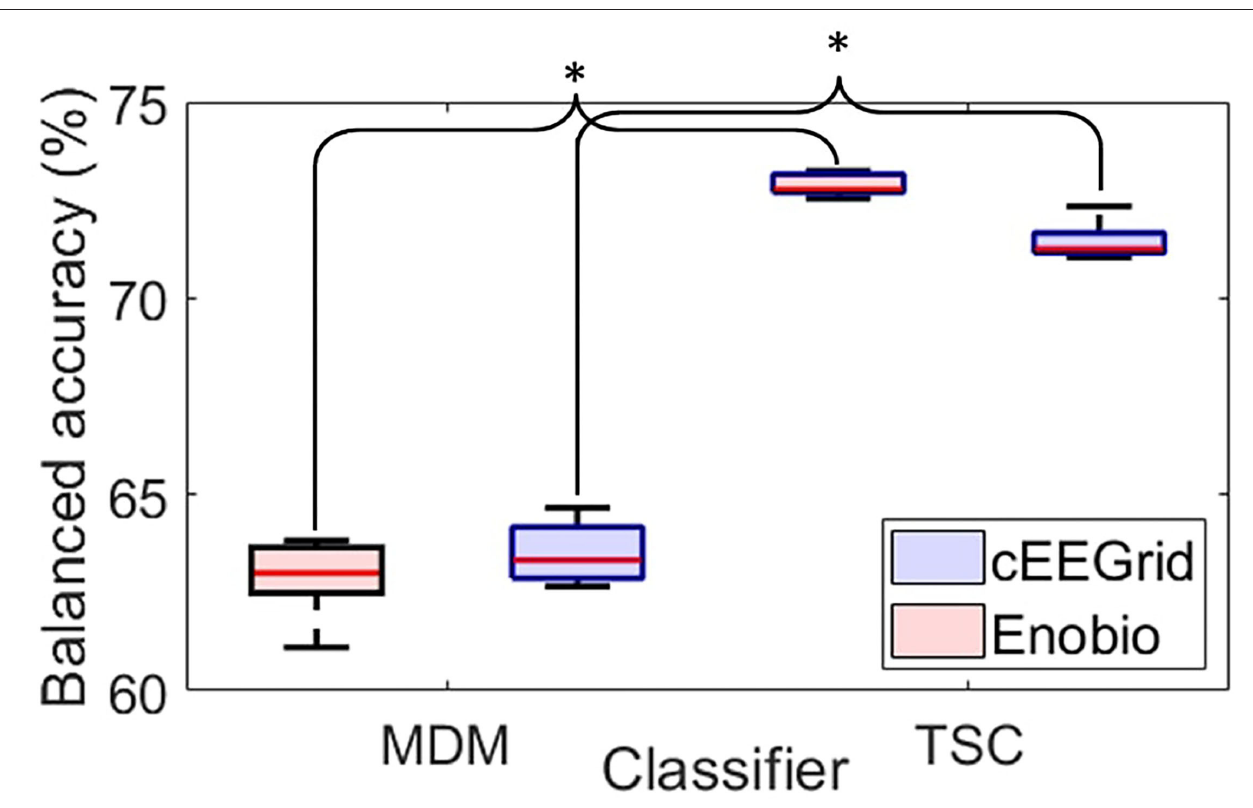
FIGURE 5 | Boxplots of the balanced accuracy distribution over the 5-folds cross-validation for the Minimum Distance to the Mean classifier (MDM–left-hand side) and the Tangent Space Classifier (TSC–right-hand side) for the cEEGrid (blue) and the Enobio (red) data. For each box, the central red line corresponds to the median, the top and bottom edges indicate the 25 and 75 th percentiles, and the whiskers extend to the most extreme data points not considered outliers. * p <